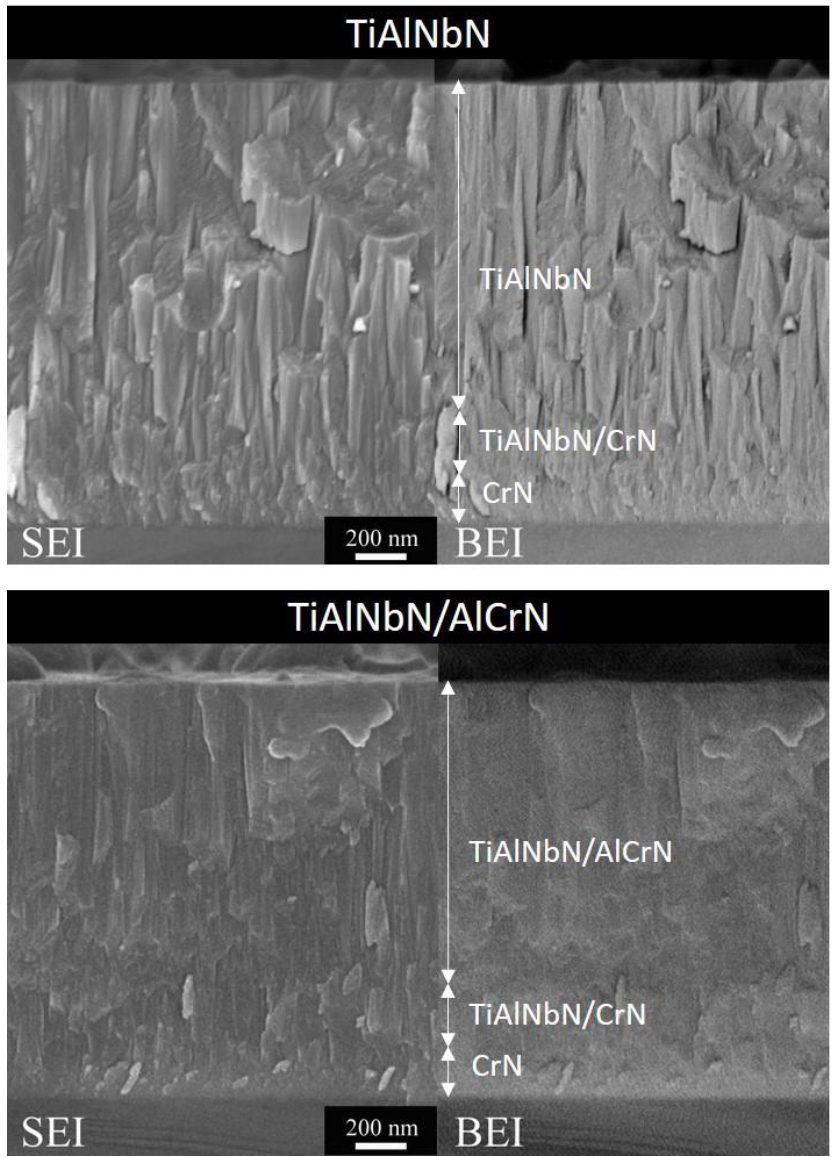
Figure 4. Cross-sectional SEM micrographs of the deposited TiAlNbN and multilayered TiAlNbN/AlCrN coatings showing secondary electron images (SEI) and backscattered electron images (BEI).